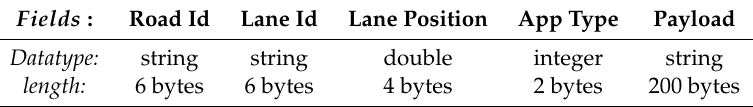
Table 7. Customized application layer packet